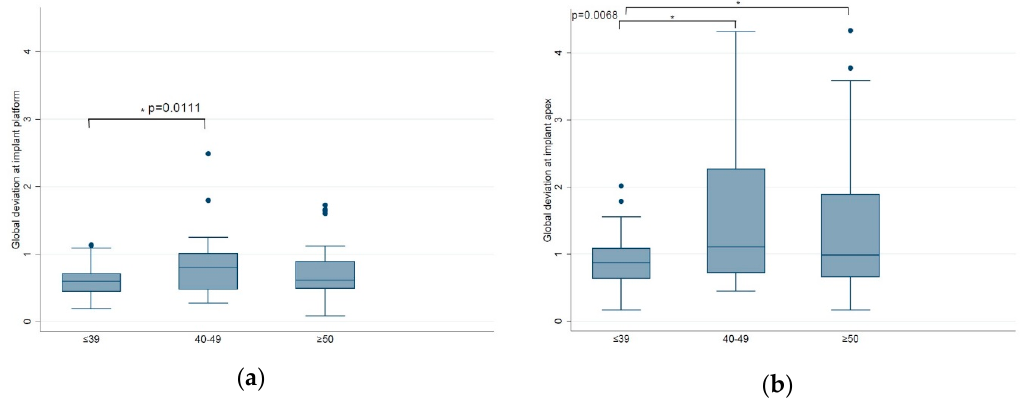
Figure 10. Box plots of the global deviation at implant: ( a ) platform and ( b ) apex of the three operator age groups.